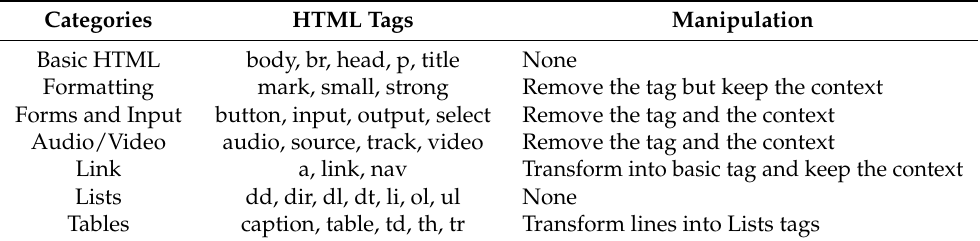
Table 1. Different manipulation on tags according to the category.